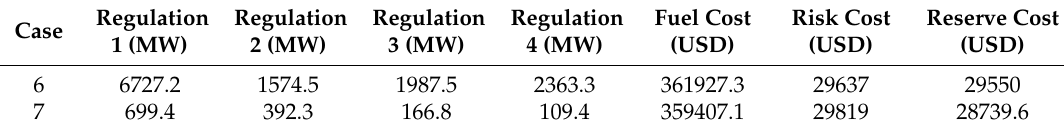
Table 5. Comparison of simulation results for Case 6 and Case 7. Table 6. Comparison of simulation results for Case 6 and Case